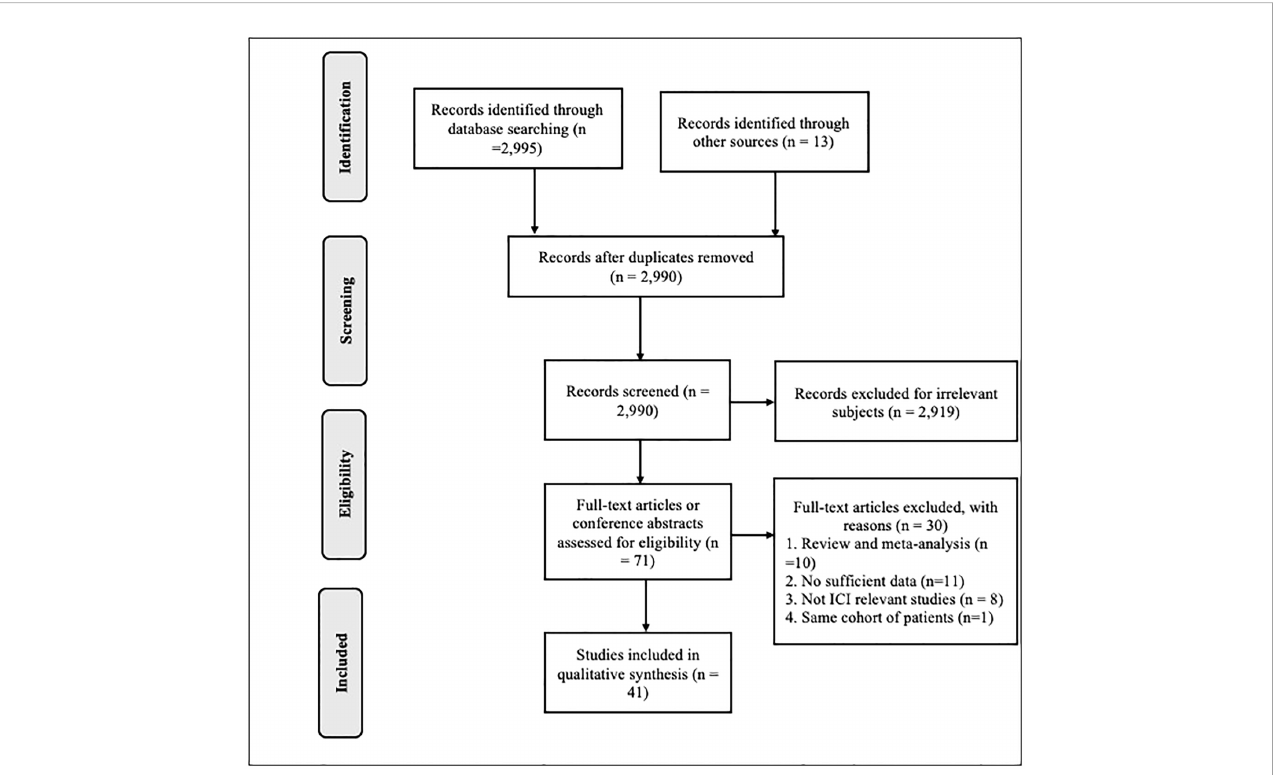
FIGURE 1 Preferred Reporting Items for Systematic Review and Meta-Analysis (PRISMA) fl ow diagram of articles identi fi cation and selection. PPI, proton pump